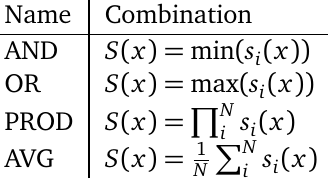
into a single i